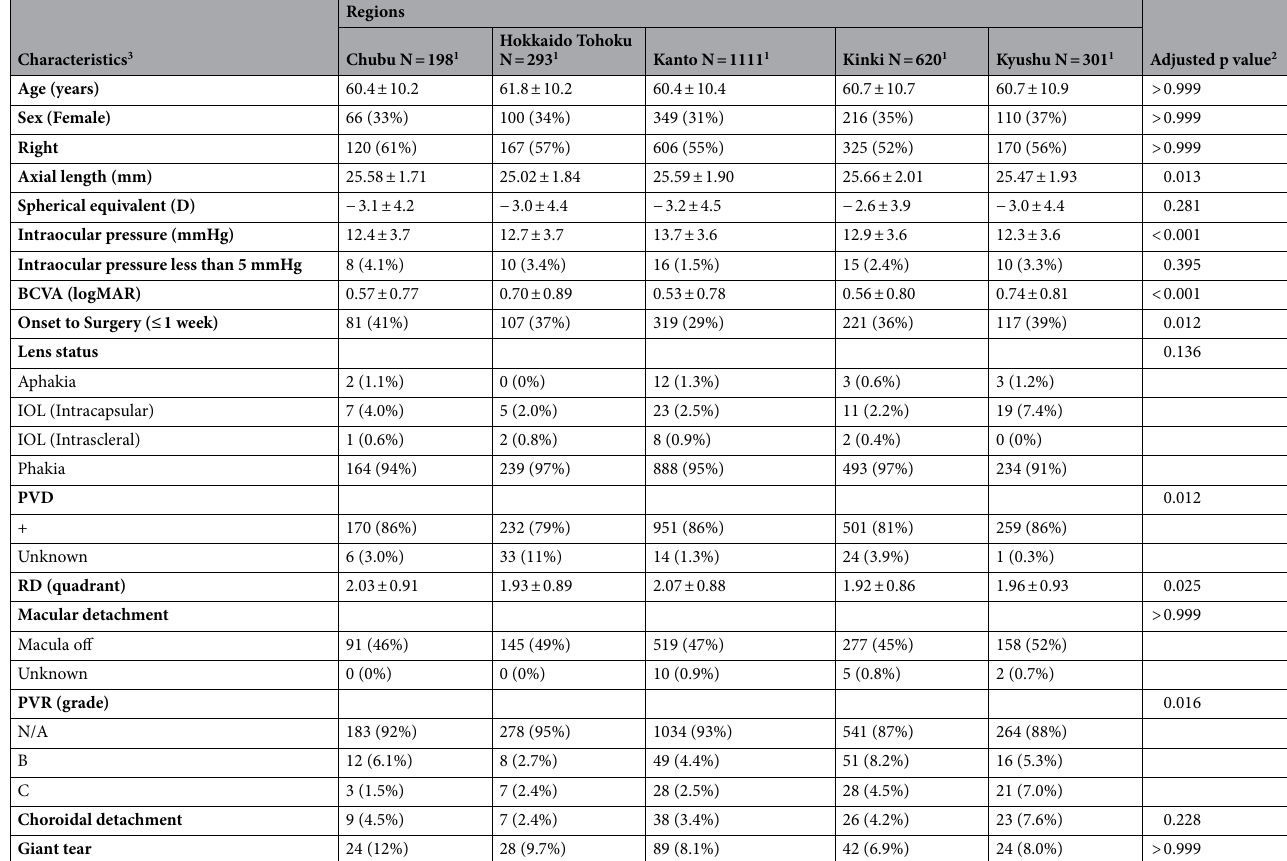
Table 1. Preoperative background of subjects by regions. 1 Mean ± SD; n (%). 2 Kruskal-Wallis rank sum test for Continuous data; Fisher’s Exact Test for Count Data with simulated P value. Holm correction for multiple testing. 3 BCVA: best corrected visual acuity, IOL: intraocular lens, PVD: posterior vitreous detachment, RD: retinal detachment, PVR: Proliferative